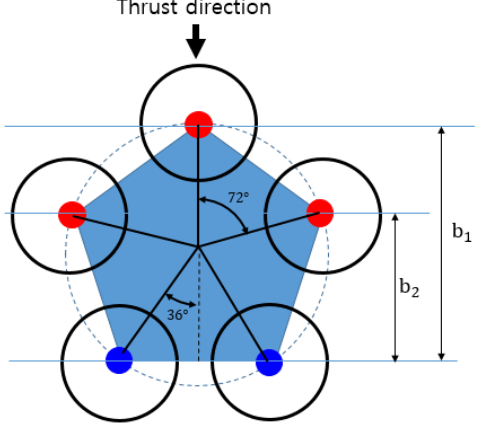
Figure 2. Top view of PSB [6].